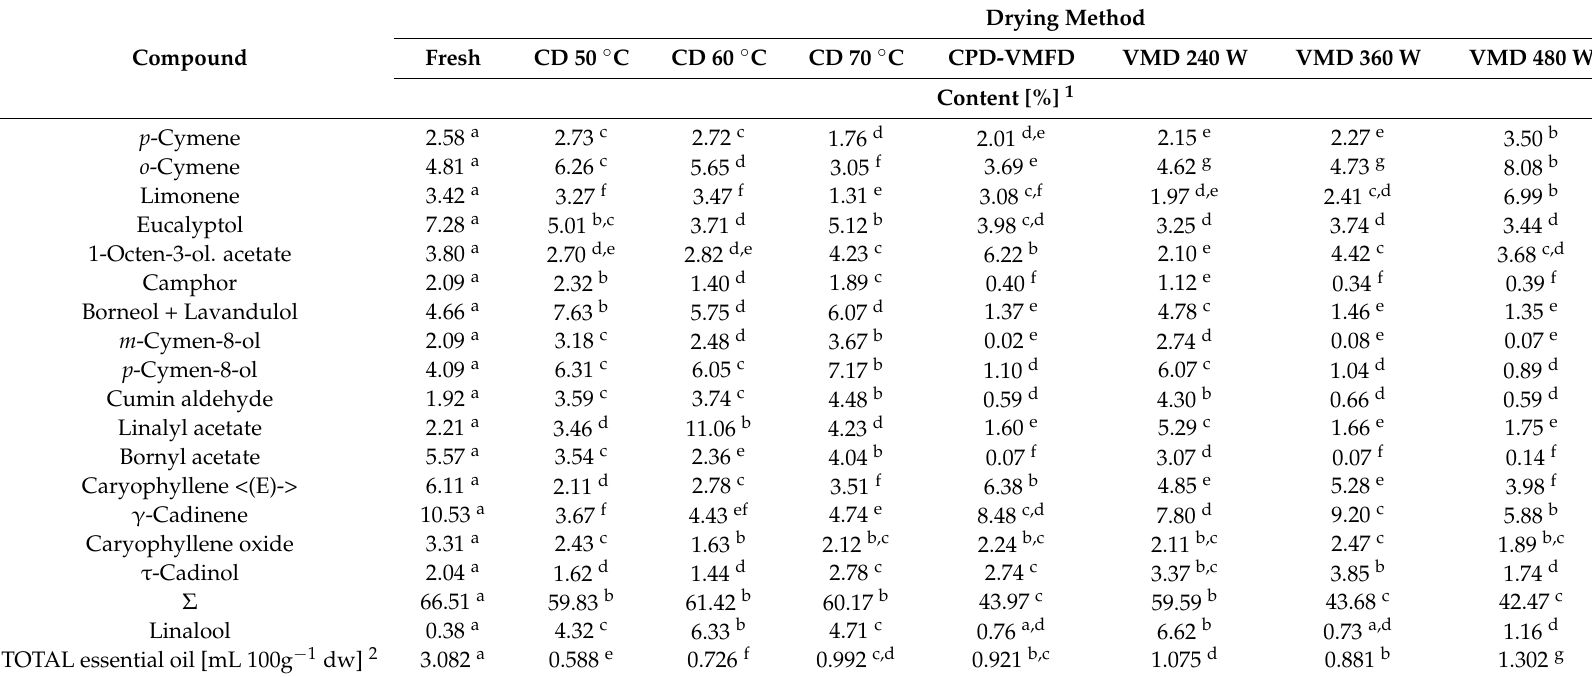
Table 3. Variability of major volatile constituents, linalool, and total essential oil of true lavender leaves caused by various drying methods.